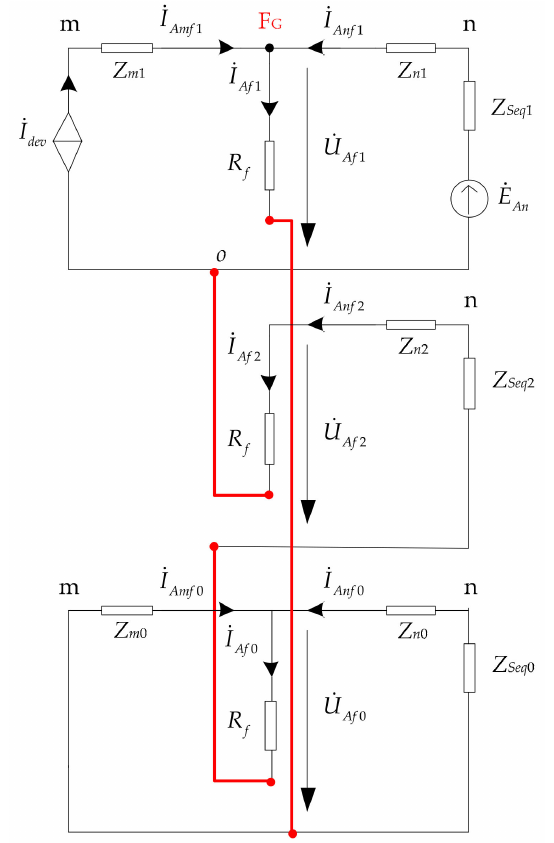
Figure 3. Compound sequence network under the phase-A-to-ground fault of the hybrid